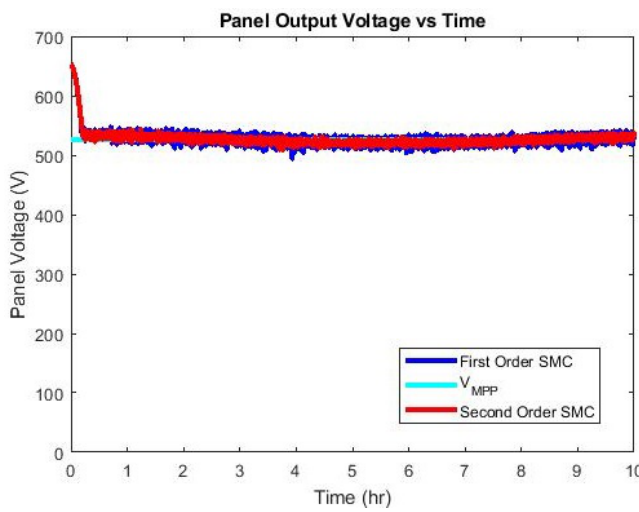
Figure 15. PV array output voltage over the changing